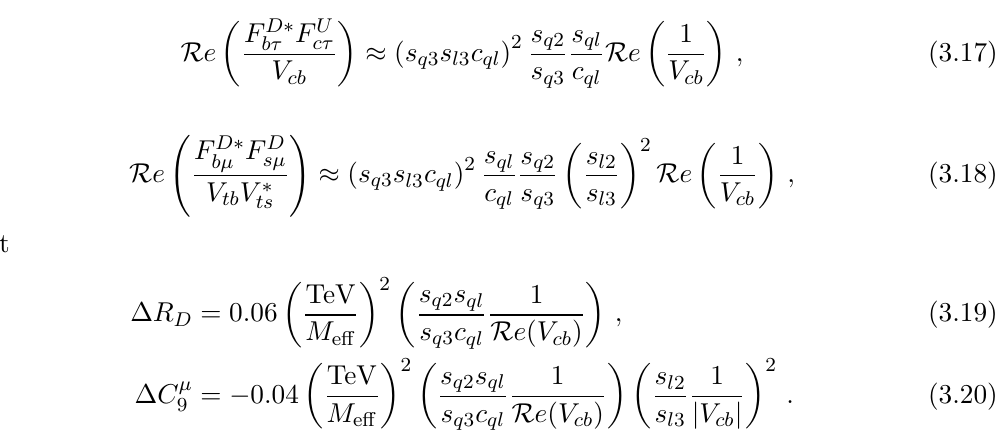
Figure 2 . Isolines of the charged current (CC, red solid lines) and of the neutral current (NC, blue dashed lines) anomaly in the extended model for ∆ R 0 . 2 / 6 , 0 . 3 / 6 , 0 . 4 / 6 , 0 . 6 / 6 , 0 . 8 / 6 {